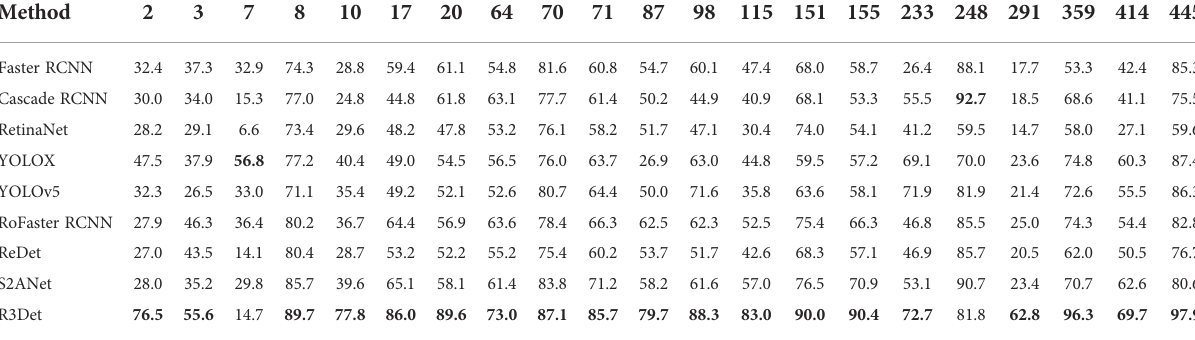
The bold numbers in the table indicate the highest values of the experimental